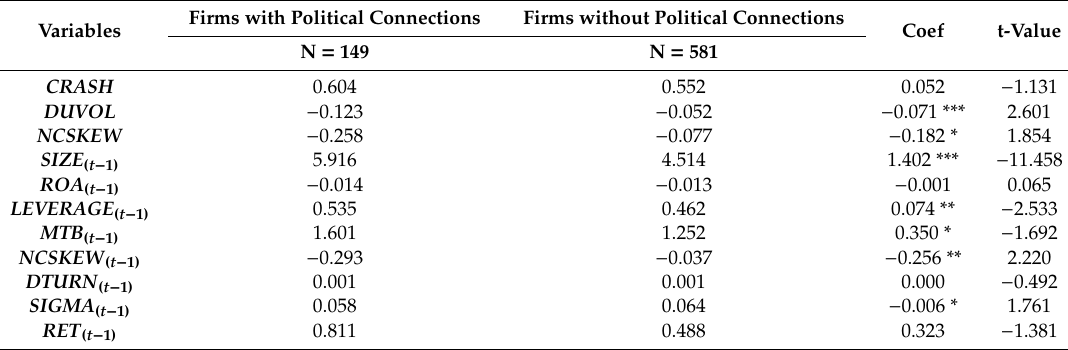
Table 4. Characteristics of politically connected and non-politically connected firms.